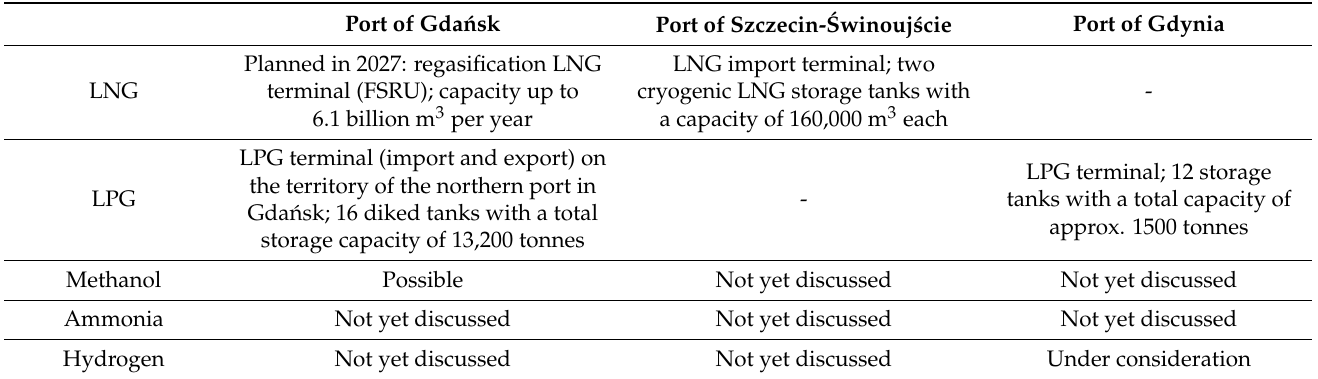
Table 9. Alternative fuel bunkering infrastructure: existing, planned, and under consideration.